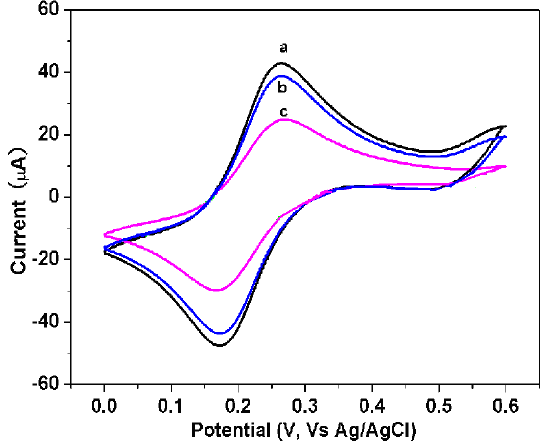
Figure 2. Different steps of cyclic voltammograms of nano-gold (Au)-MWCNTs/PDDA composite-modified electrode.